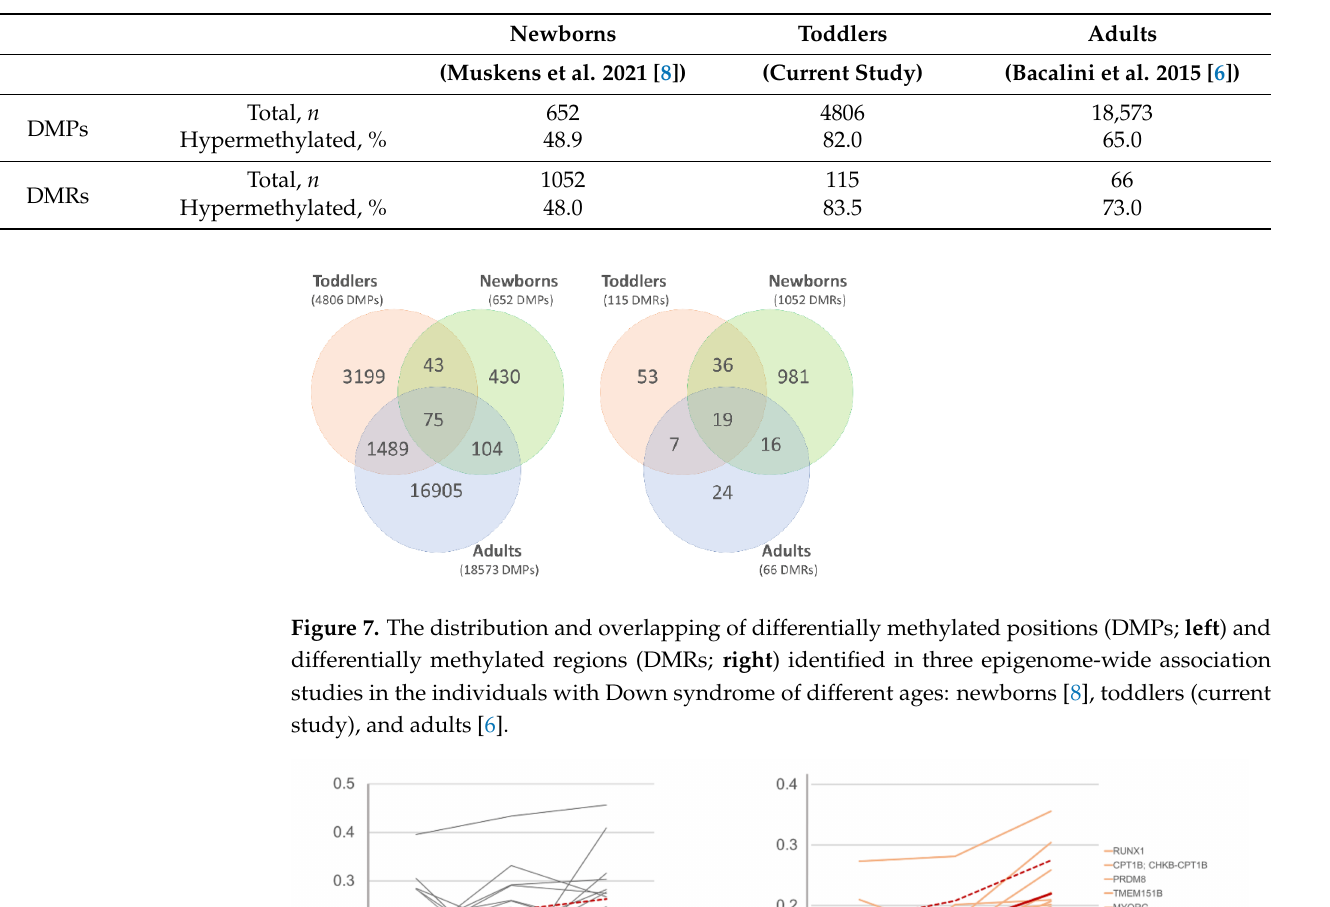
Table 4. A summary of the results of the differential DNA methylation analyses in three age groups of individuals with DS; the statistics on differentially methylated positions (DMPs), or CpG-sites, and differentially methylated regions (DMRs) are shown.